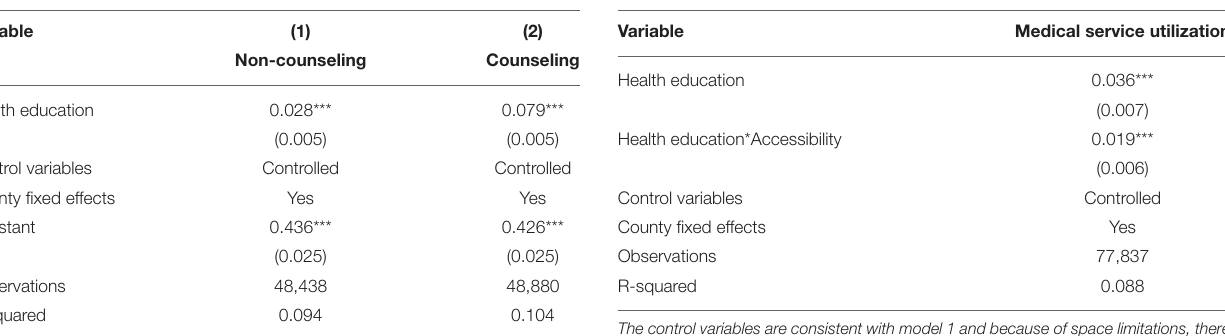
TABLE 8 | Moderating effect of accessibility in the effect of health education on medical service utilization of the migrants.